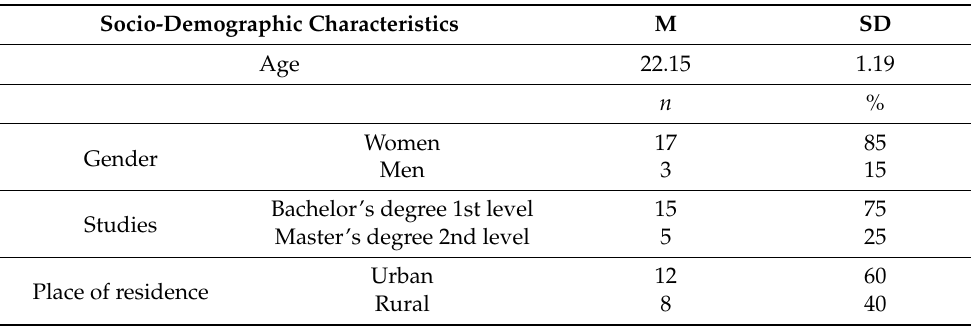
Table 3. Socio-demographic characteristics of